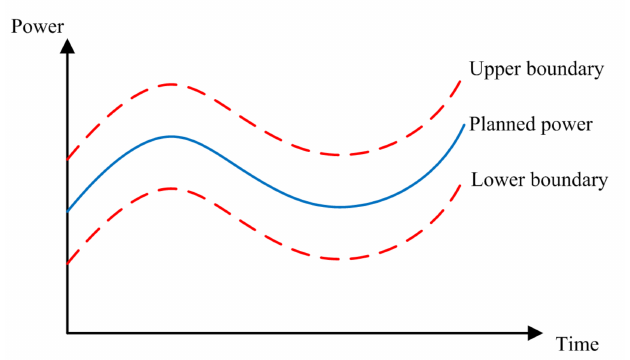
Figure 1. ARWP of a wind farm.